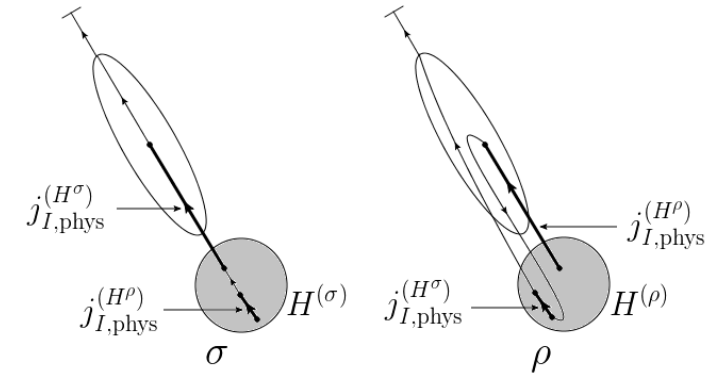
(cid:27) ) (cid:26) ) and j ( H , which are marked bold. This (cid:12)gure I; phys I; phys (cid:27) ) (cid:26) ) and j ( H are di(cid:11)erent, then we will have more than one propagator in J ( H I; phys I; phys